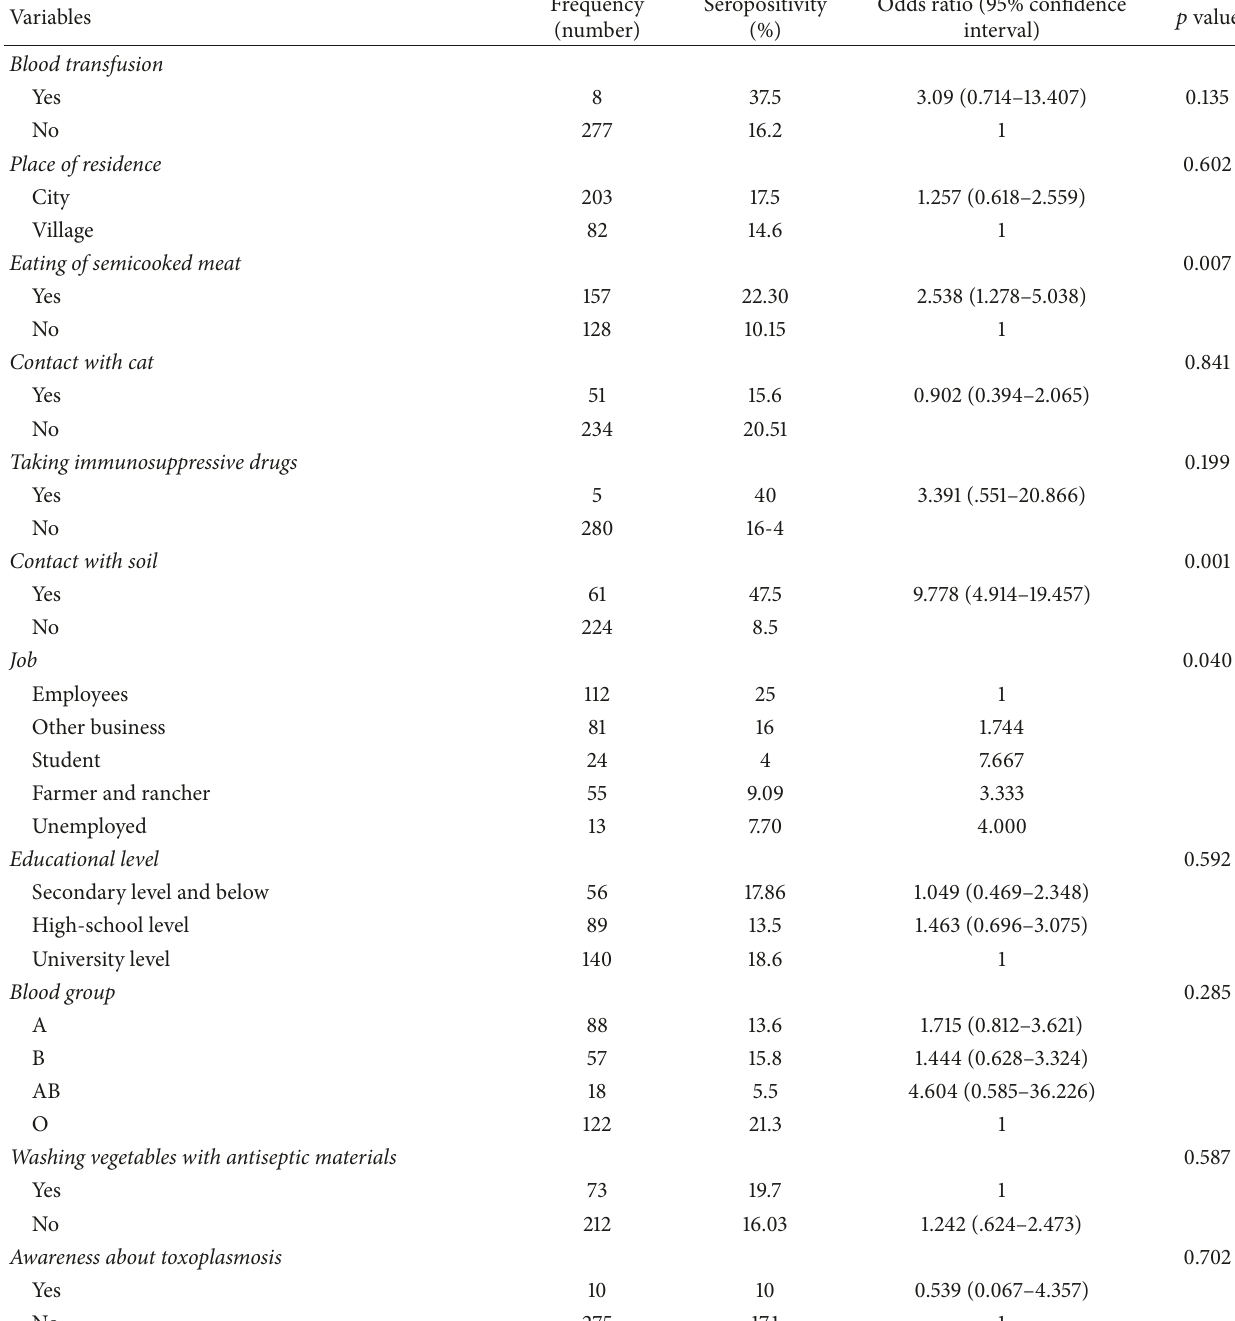
Table 1: Risk factors analysis of seropositivity to toxoplasmosis among blood donors in southwest